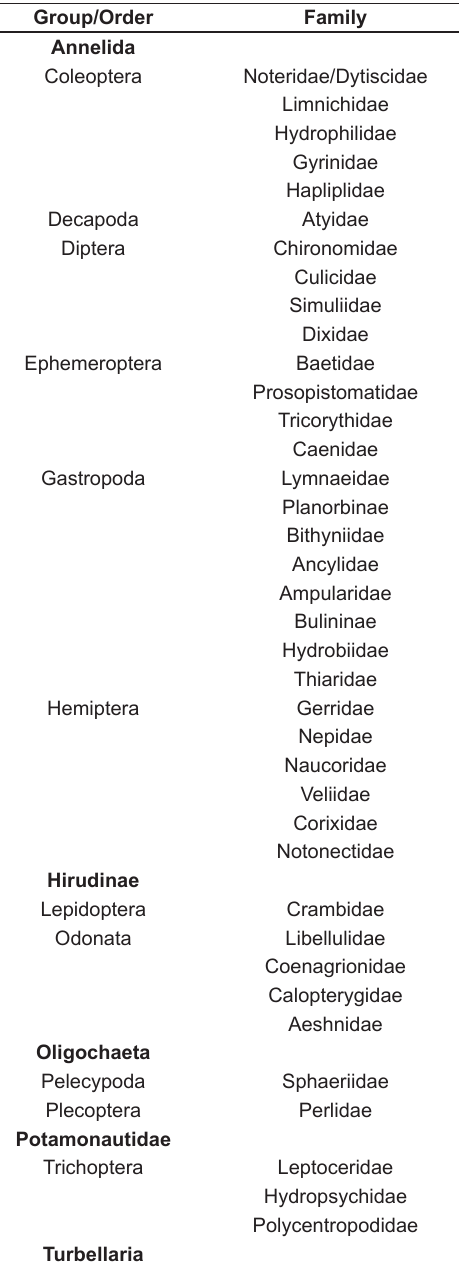
Table 3. Macroinvertebrate families and orders recorded from sample sites. Following ZISS protocol, sampled taxa are identified mostly to family level (Lowe et al., 2012a). However, there are some exceptions, including Annelida, Oligochaeta, and Turbellaria which are only required to be identified to subphylum or class and are listed below in